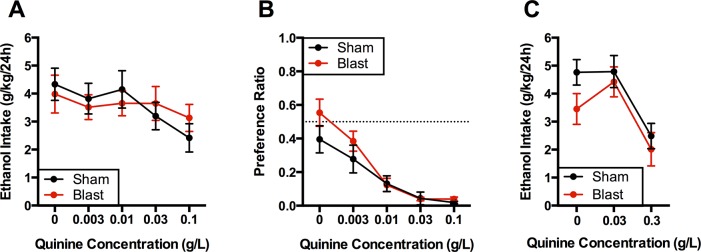
Quinine adulteration and taste preference tests.A) Quinine was added to ethanol in weekly tests of quinine adulteration in a two-bottle choice paradigm (water vs. 20% ethanol+quinine). B) Quinine preference was determined in a two-bottle choice paradigm (water vs. water+quinine). C) An additional quinine adulteration test was performed in a subset of rats with a higher maximum quinine concentration. N = 12/group in A, B. N = 6-9/group in C.